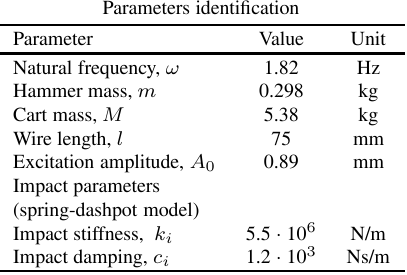
Table 3 Parameters identi fi